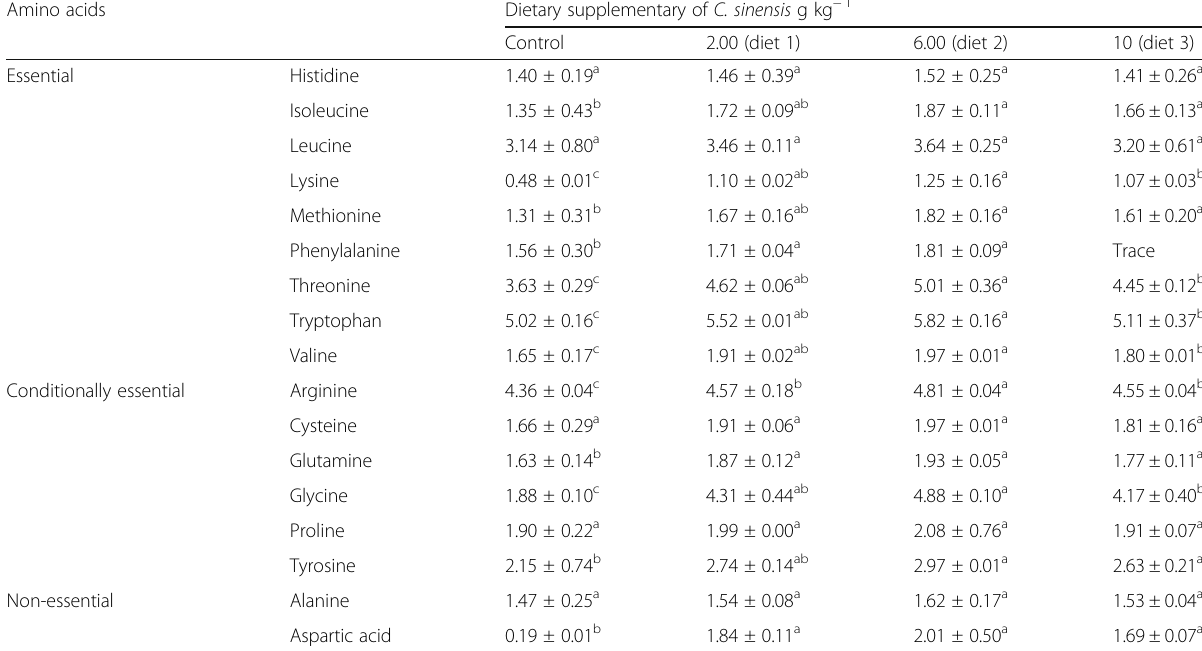
Table 5 Amino acid (g kg − 1 ) profile of Catla catla fed with C. sinensis -supplemented diets Amino